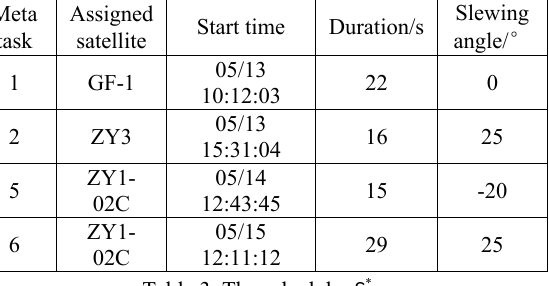
Table 3. The schedule *